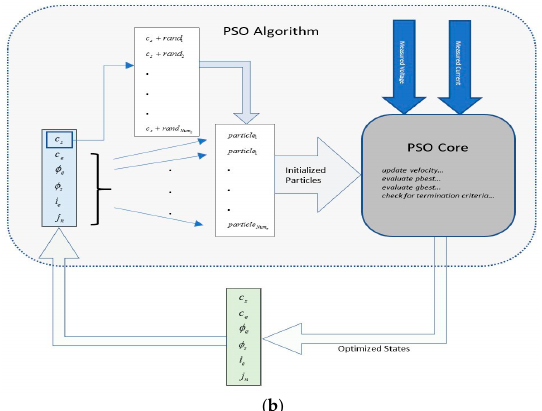
Figure 2. ( a ) State of charge (SOC) estimation overview; ( b ) schematic of the particle swarm optimization (PSO)-based SOC estimation algorithm.